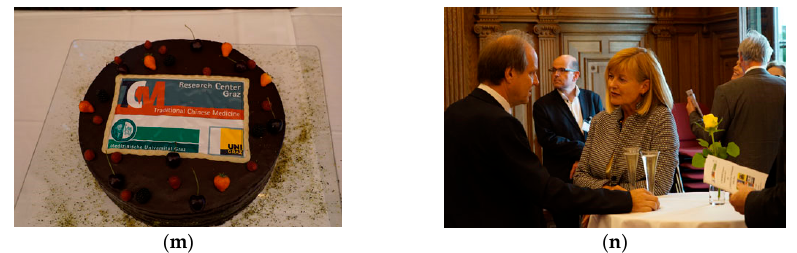
Figure 17. Tenth Anniversary of the TCM Research Center Graz ( a – n ). The interuniversity TCM